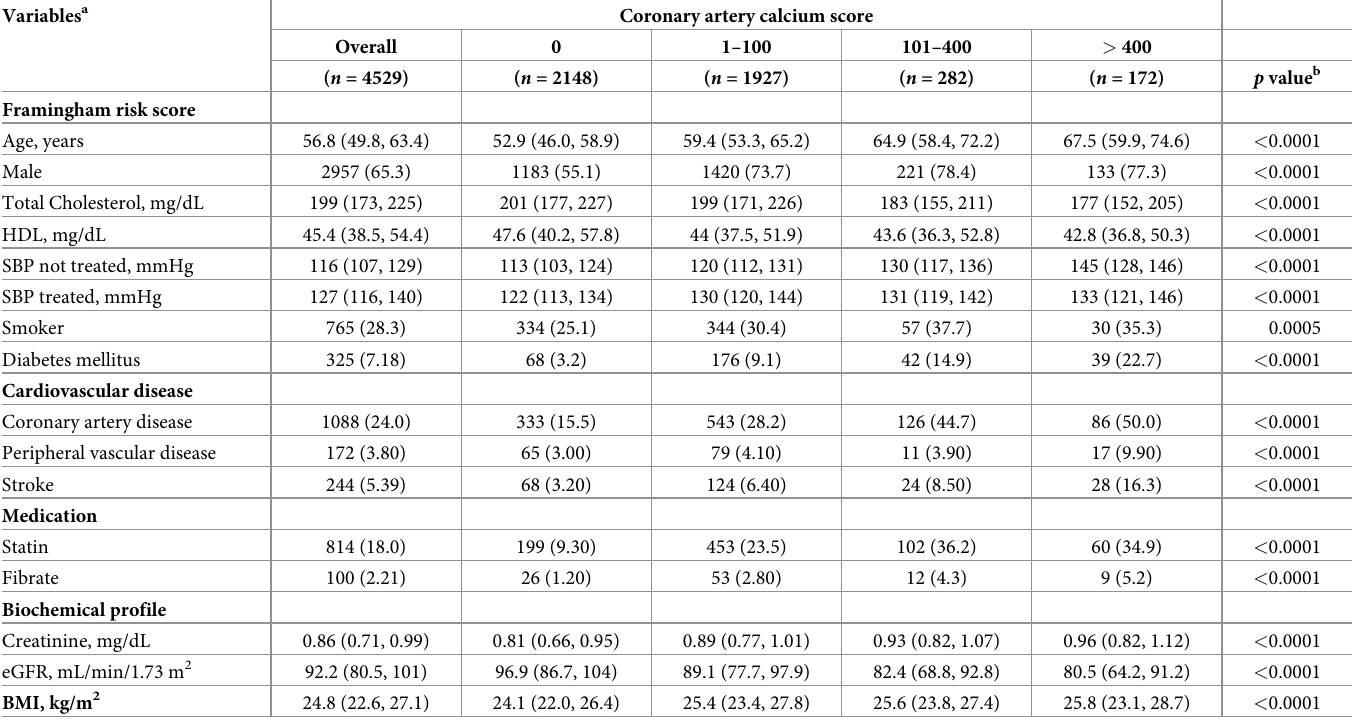
Table 1. Baseline demographics and clinical characteristics according to coronary artery calcium scores.